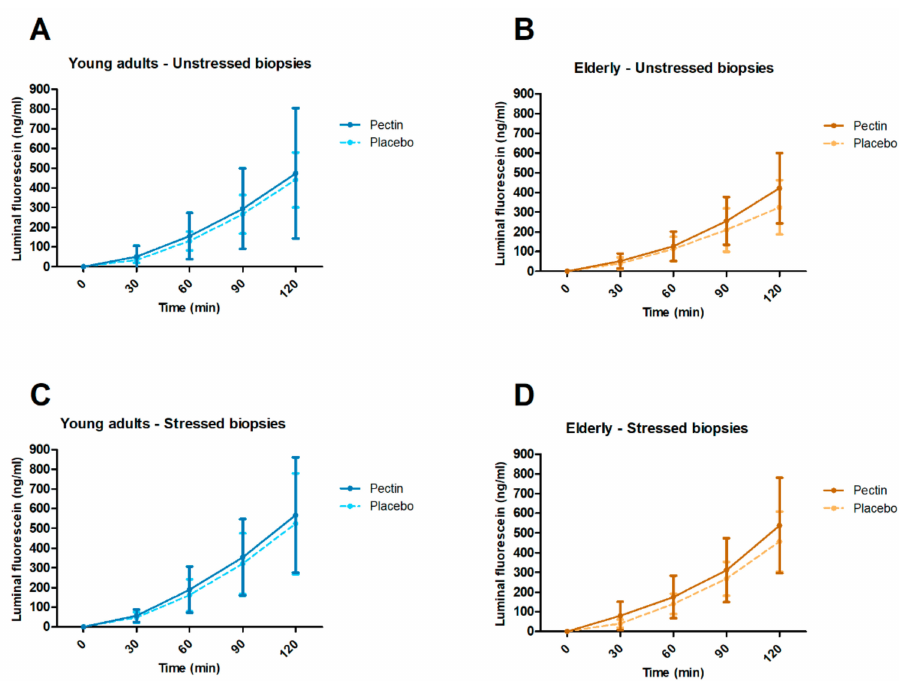
Figure 6. Intestinal permeability ex vivo after four weeks of pectin (fixed lines) and placebo (dashed lines) intervention in young adults and elderly. Analyses were conducted by mounting fresh sigmoid biopsies in an Ussing chamber system and assessing luminal fluorescein concentration at t = 0, 30, 60, 90, and 120 min. ( A ) Luminal fluorescein concentration in young adults in unstressed biopsies. ( B ) Luminal fluorescein concentration in elderly in unstressed biopsies. ( C ) Luminal fluorescein concentration in young adults in biopsies stressed by 1 µ g / mL Compound 48 / 80 at t = 0. ( D ) Luminal fluorescein concentration in elderly in biopsies stressed by 1 µ g / mL Compound 48 / 80 at t = 0. Means and standard deviations are shown. Sample sizes varied because baseline values of some sigmoid biopsies did not meet quality criteria for viability. Within age groups, luminal fluorescein concentrations were compared between intervention groups with random intercept linear mixed models. p -values per time point were corrected for multiple testing by calculating the false discovery rate (FDR) of